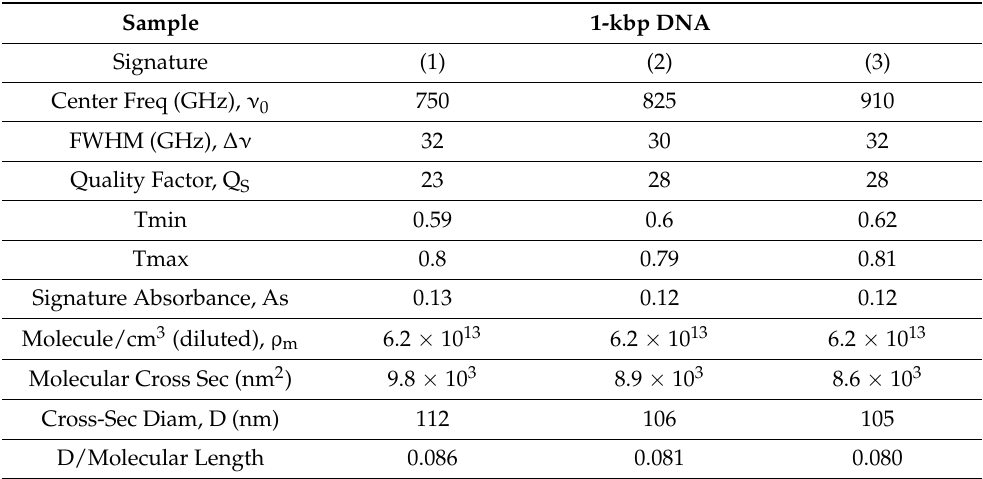
Table 1. Spectroscopic and optical parameters for three prominent absorption signatures in si-RNA and 50-bp DNA samples .